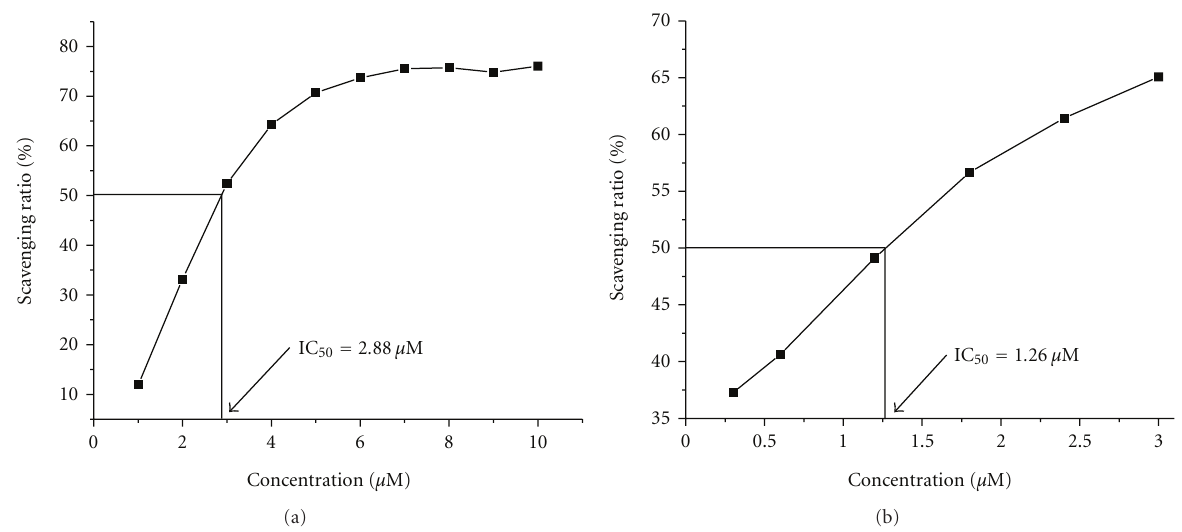
Figure 7: Plots of antioxidation properties for the Cu(II) complex. (a) Represents the hydroxyl radical scavenging e ff ect (%) for the Cu(II) complex. (b) Represents the superoxide radical scavenging e ff ect (%) for the Cu(II)